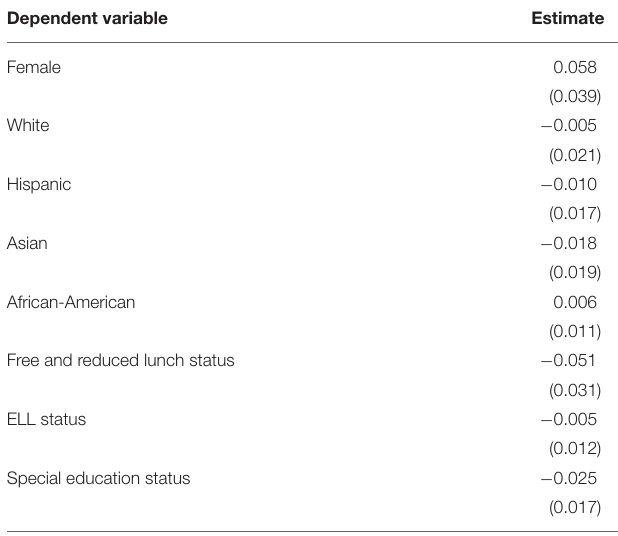
TABLE 6 | Auxiliary regressions of baseline covariate balance.